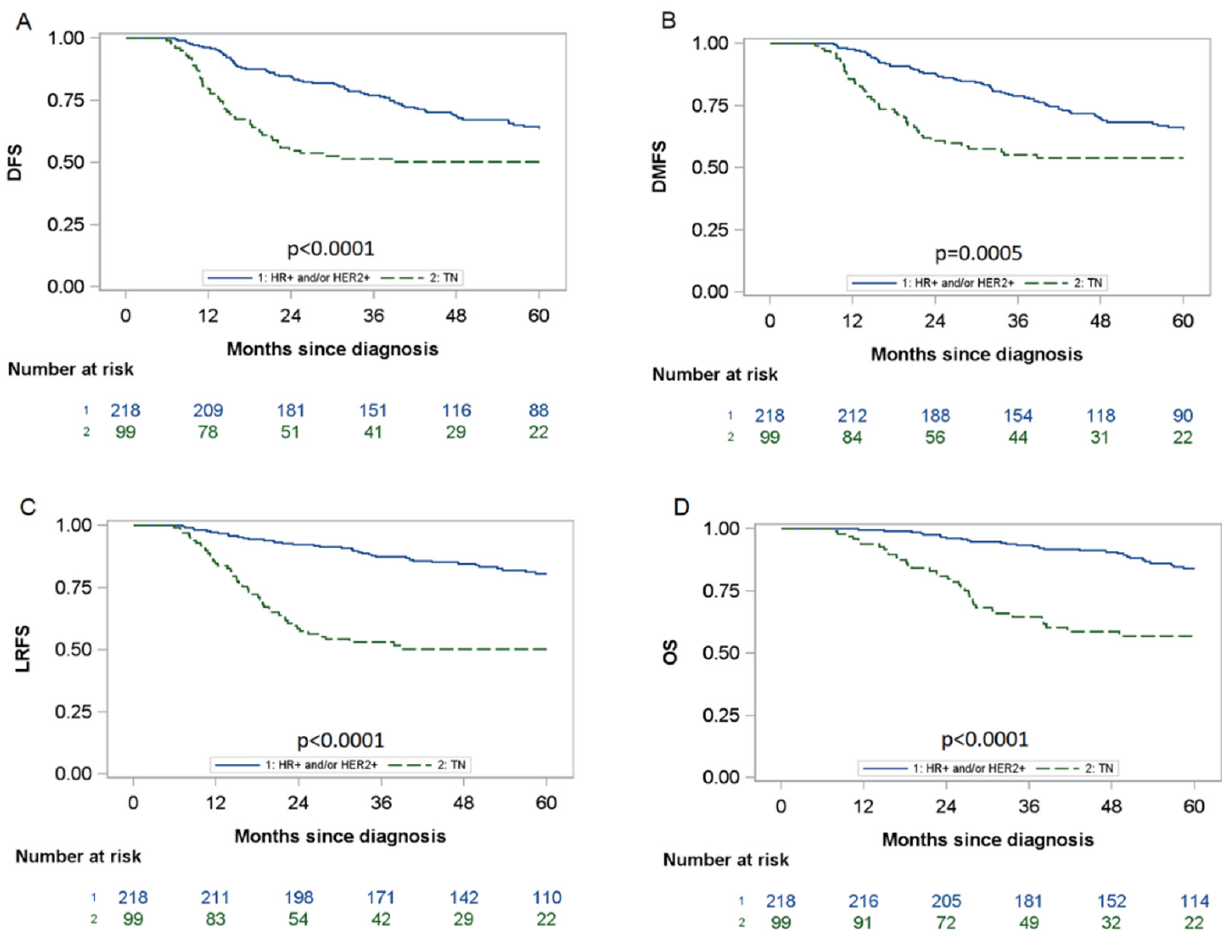
Figure 1. DFS, DMFS, LRFS and OS by triple-negative status. The blue line corresponds to patients with HR+ and/or HER2+ tumours, whereas the green line corresponds to patients with triple-negative (TN) tumours. ( A ) 5-year disease-free survival by breast cancer subtype; ( B ) 5-year distant metastasis-free survival by breast cancer subtype; ( C ) 5-year locoregional relapse-free survival by breast cancer subtype; ( D ) 5-year overall survival by breast cancer subtype.